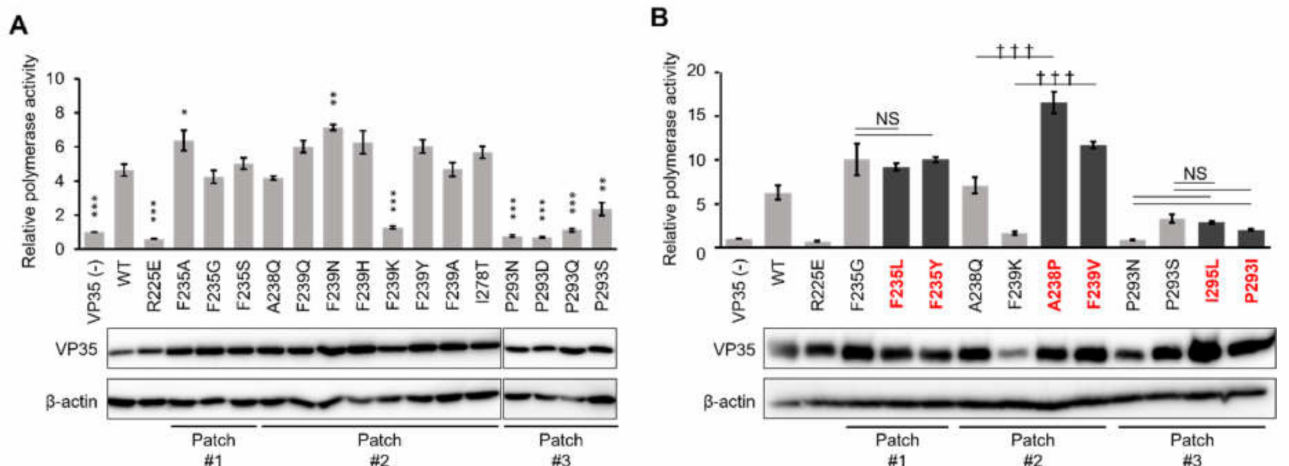
Figure 2. Attenuation of polymerase cofactor activity of hydrophobic patch-disrupted mutants of VP35. Viral polymerase activity was assessed by minigenome assay. HEK293T cells were transfected with an empty vector (VP35(-)), WT-, or mutant VP35-expressing plasmids together with expression plasmids for EBOV NP, VP30, L, T7 RNA polymerase, and a plasmid providing the EBOV minigenome encoding a fused firefly luciferase reporter gene under the control of the T7 RNA polymerase promoter. A Renilla luciferase-expression plasmid was cotransfected as a control for transfection efficiency. Minigenome activity was quantified by measuring firefly luciferase activity, and this was normalized to the level of Renilla luciferase expression. Each patch-disrupted mutant was analyzed to compare with wild-type VP35 ( A ) and patch-retained mutants ( B ). Each bar represents mean ± standard error (SE) for three independent experiments. Lower panels show Western blots for VP35 proteins and β -actin. Mutants shown in red boldface (also shown with dark bars) are those that retained the hydrophobic patch. Dunnett’s multiple-comparison test was used for the comparison to wild-type (WT) (* p < 0.05, ** p < 0.01, *** p < 0.001) ( A ). The Tukey–Kramer test was used for comparisons between the patch-disrupted and patch-retained mutants in each amino acid position (††† p < 0.001, NS: No significant difference) ( B